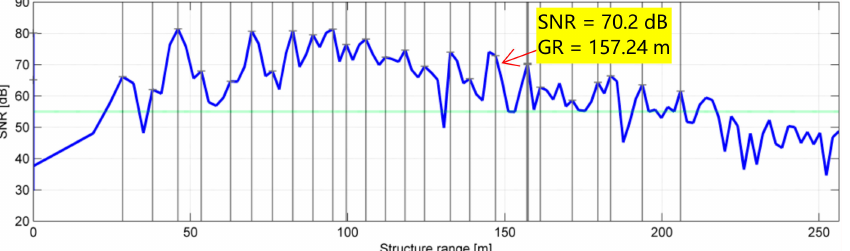
Figure 5. Range profile of the bridge deck. Bold gray line indicates the radar bin (number 76) selected for estimating the deck displacements.